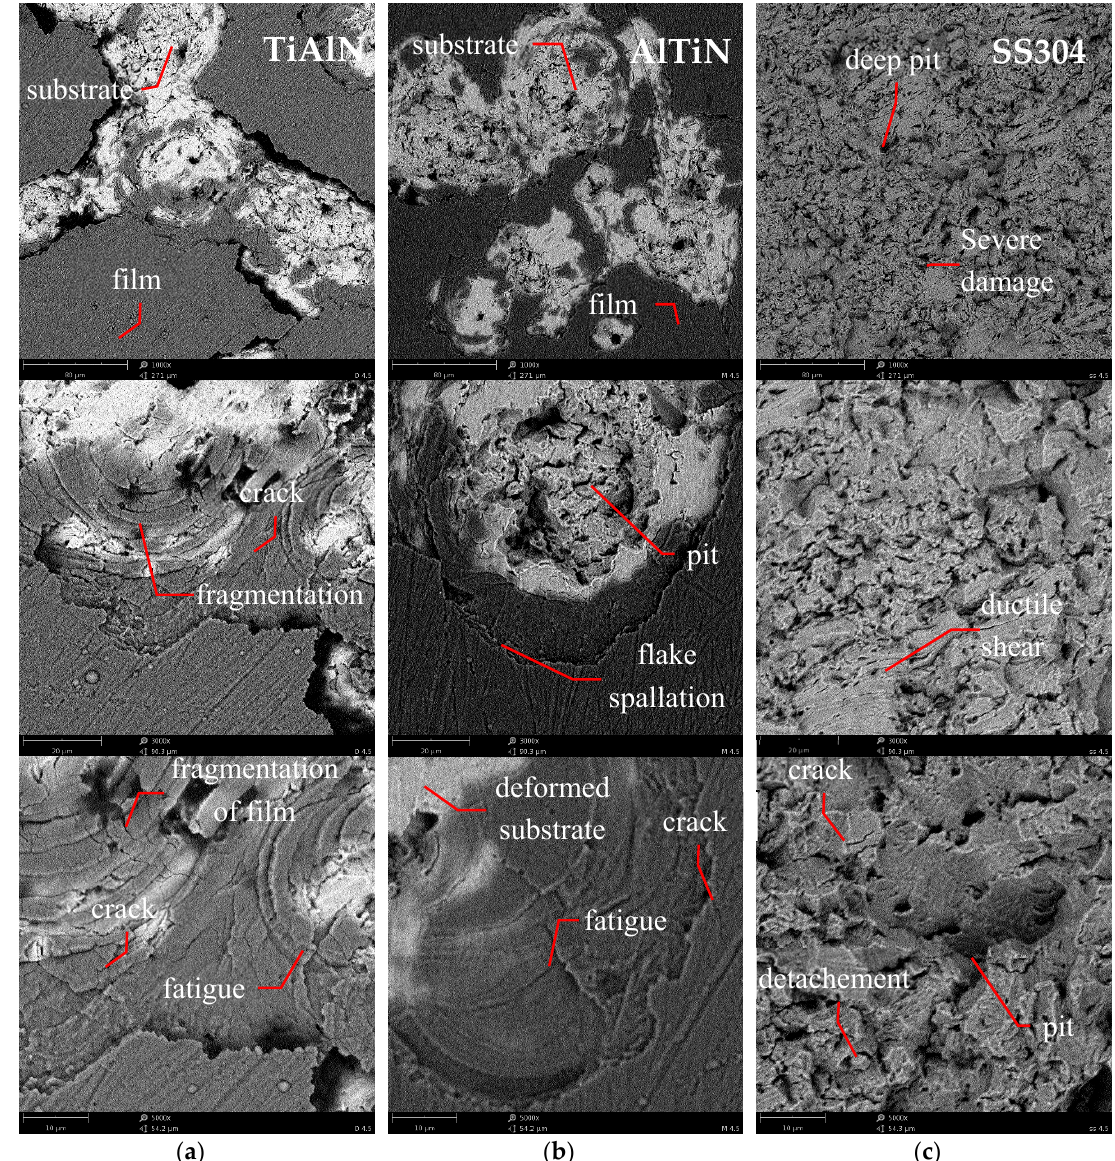
Figure 8. Comparison of cavitation ‐ eroded thin films and stainless steel, after 4.5 h of testing: column ( a ) TiAlN; ( b ) AlTiN; ( c ) SS304; SEM, 1000 × , 3000 × and 5000 ×